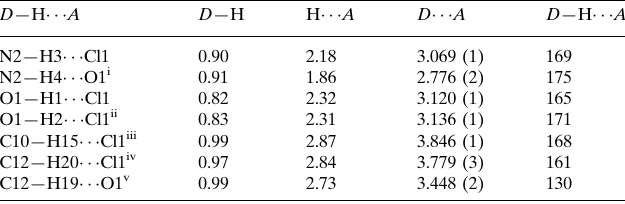
Hydrogen-bond geometry (A˚ , (cid:3)